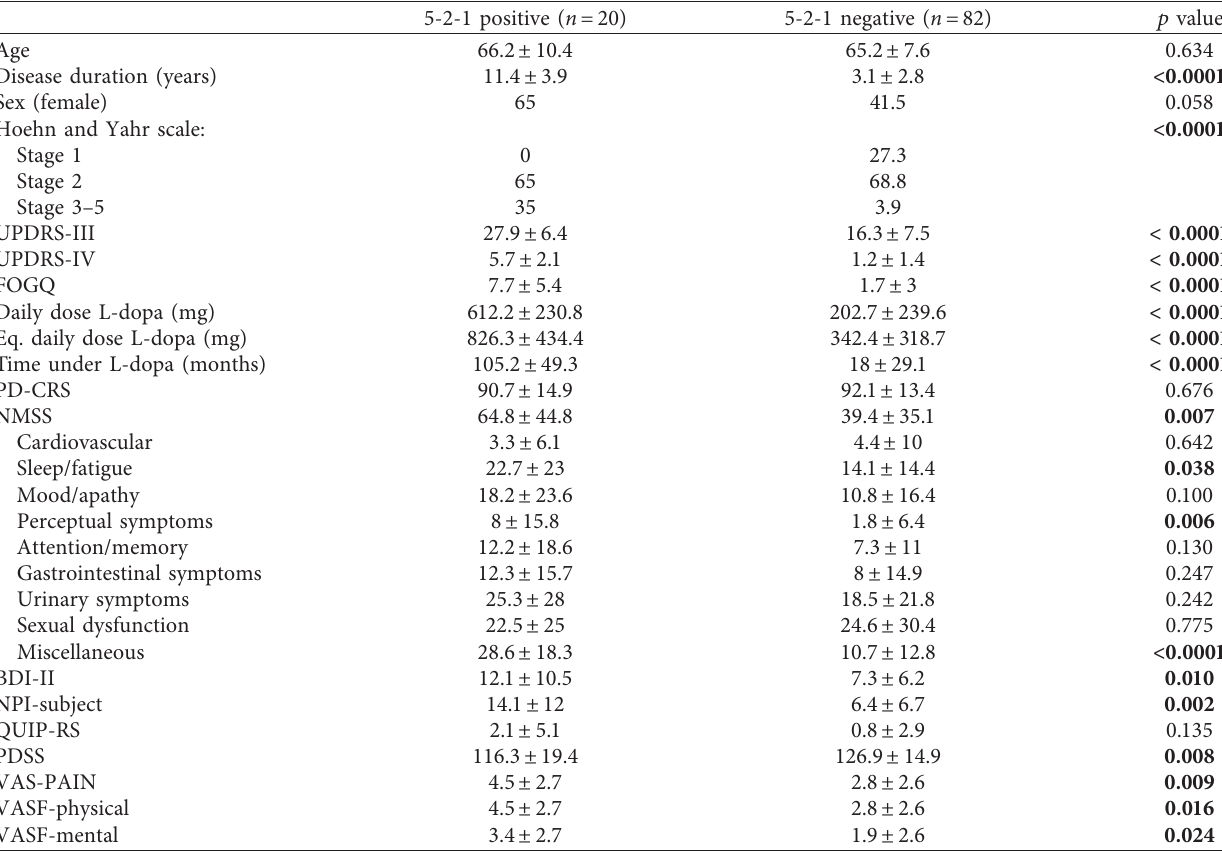
Table 1: PD-related variables in patients with 5-2-1 criteria ( n � 20) vs those with 5-2-1 negative criteria ( n �